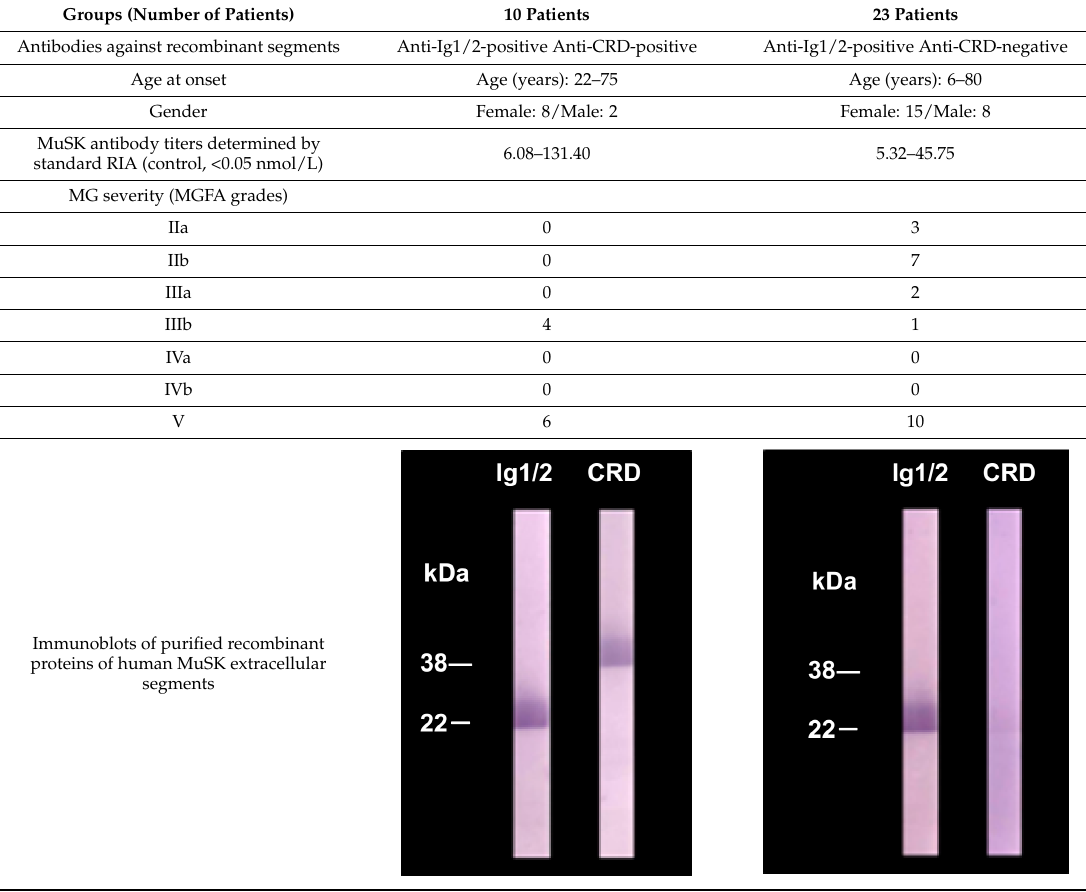
MuSK antibody titers determined by standard RIA (control, <0.05 nmol/L)